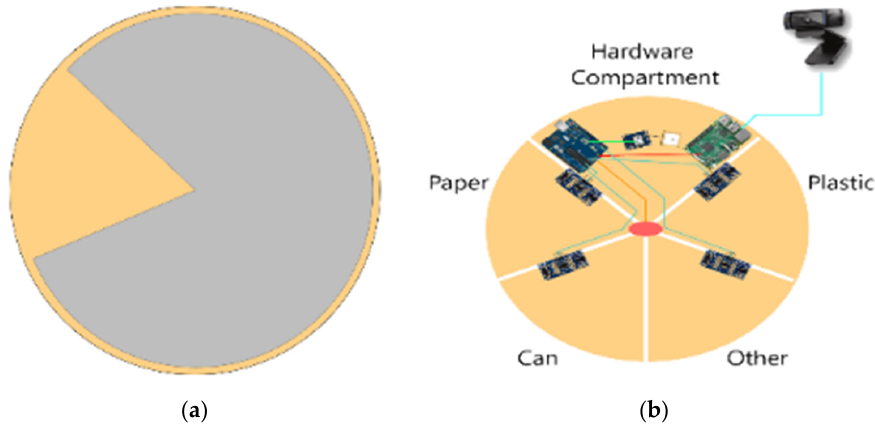
Figure 5. Hardware design for the trash bin lid ( a ) and trash bin body ( b ).